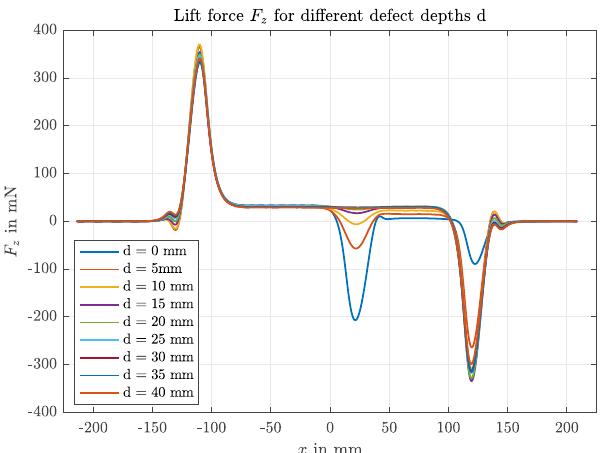
Figure 3. Measured lift force F z in LET measurement of different specimens with different slit defect depths d